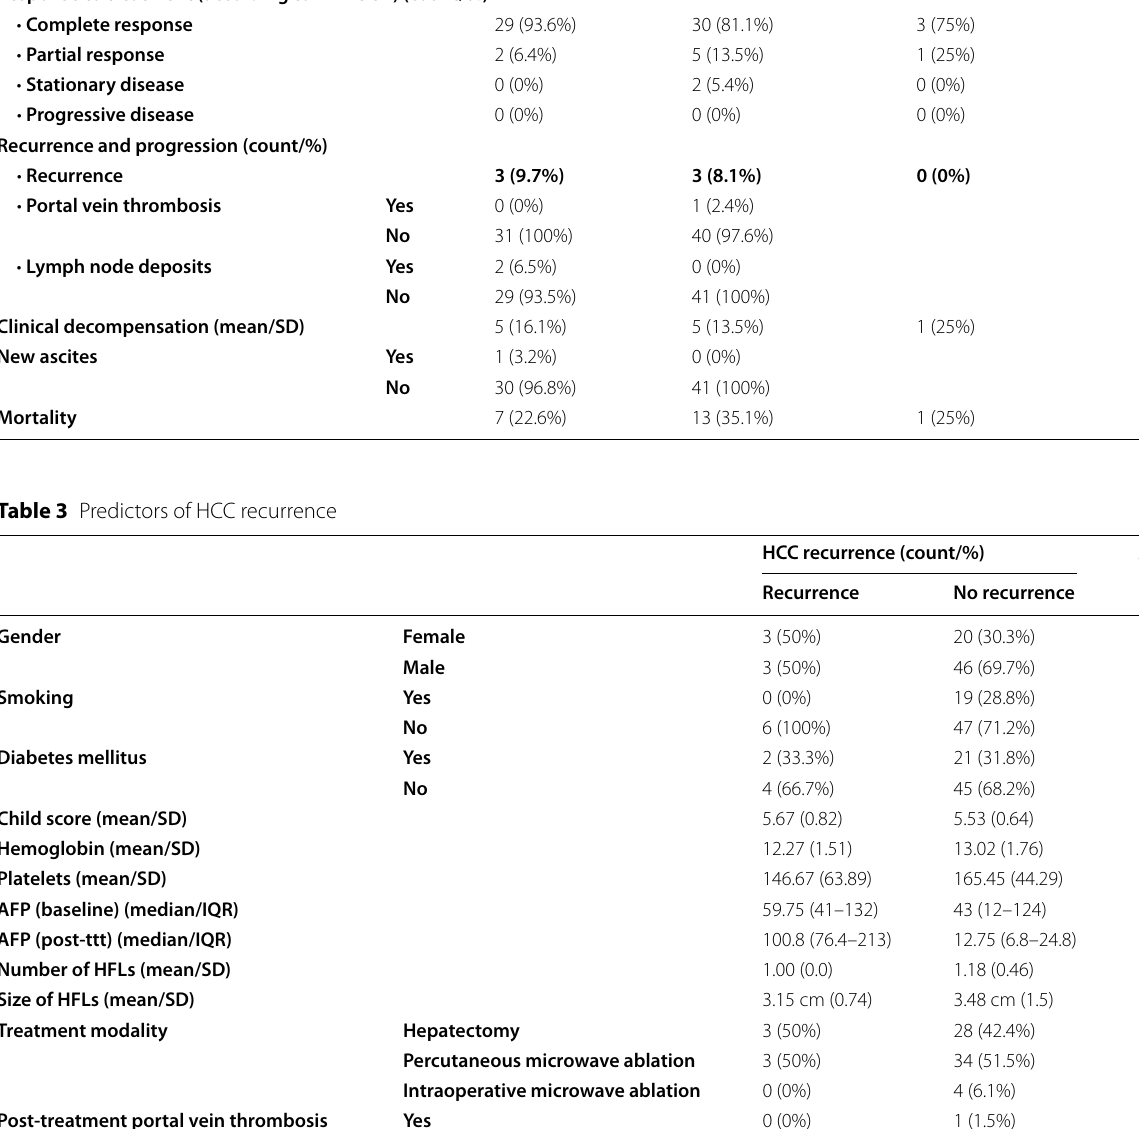
Hepatectomy ( N 31) =